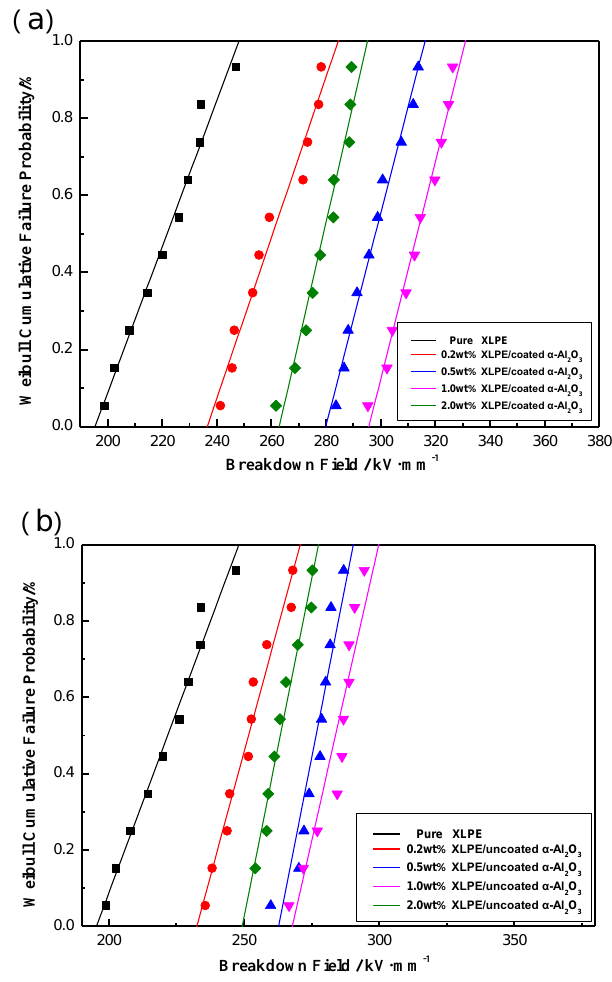
Figure 8. ( a ) Weibull plots comparing the direct current (DC) breakdown strength of pure XLPE and XLPE/α-Al 2 O 3 nanocomposites containing 0.2 wt %, 0.5 wt %, 1.0 wt %, and 2.0 wt % coated α-Al 2 O 3 and ( b ) Weibull plots comparing the DC breakdown strength of pure XLPE and XLPE/α-Al 2 O 3 nanocomposites containing 0.2 wt %, 0.5 wt %, 1.0 wt %, and 2.0 wt % uncoated α-Al 2 O 3 .